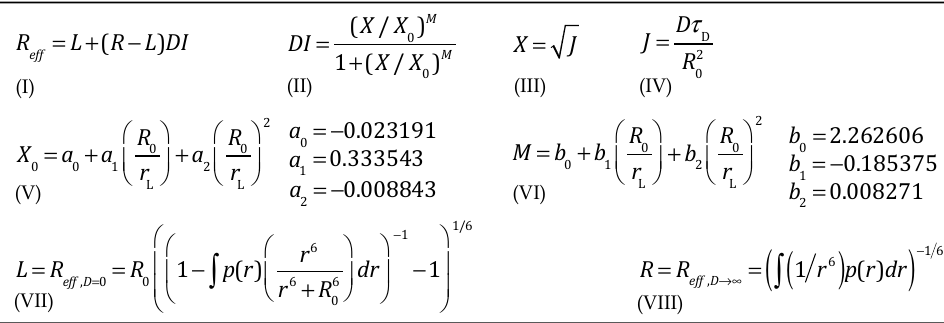
Figure 8. The Haas-Steinberg–Jacob equation (HSJE) is a closed analytical equation decomposed here into simple equations, I to VIII, for clarity. With the coefficients shown here ( a 0 to b 3 ), it is valid for R 0 9-15Å and r L 1.5-5Å.